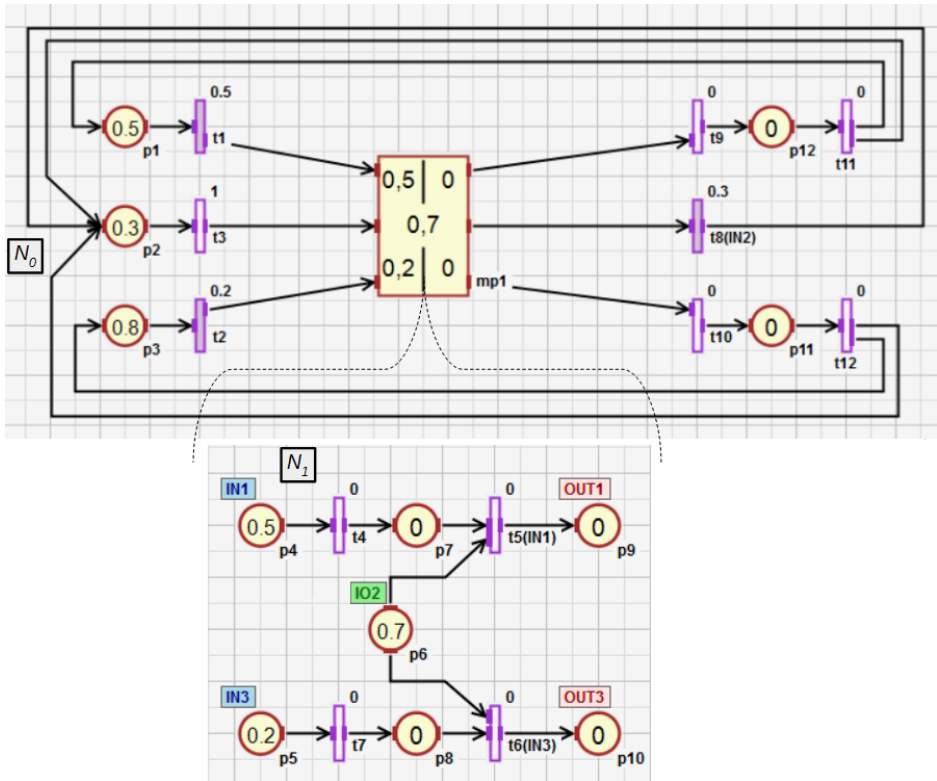
Figure 4. HFIPN graph with the macroplace having two input places, two output places and one input-output place.